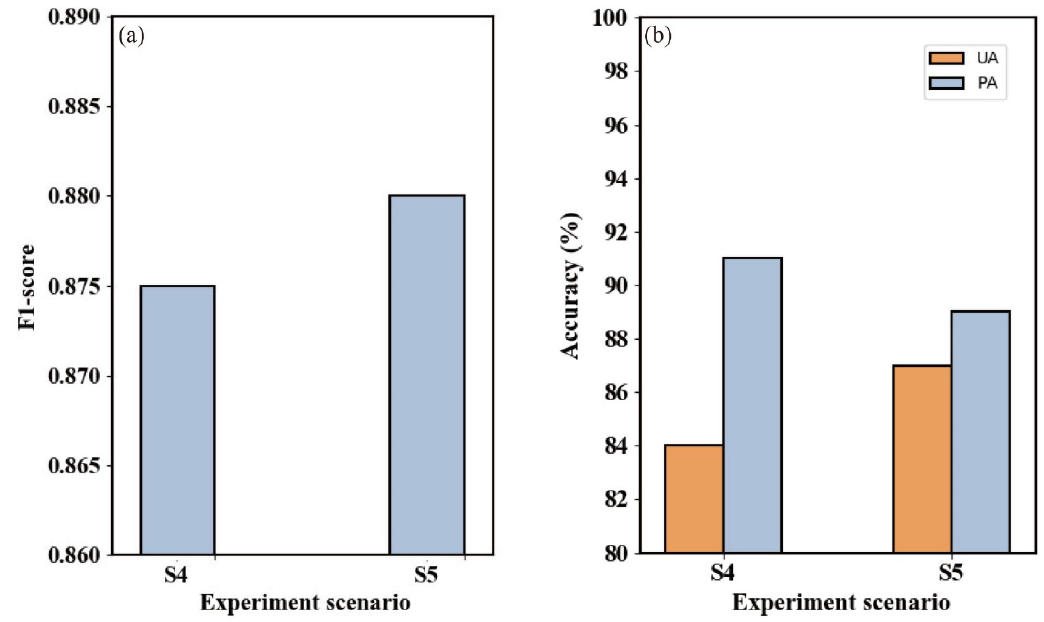
Figure 11. Comparison of classification accuracies between S4 excluding four red edge bands and S5 including four red edge bands. ( a ) F1-score comparison; ( b ) UA and PA comparison.